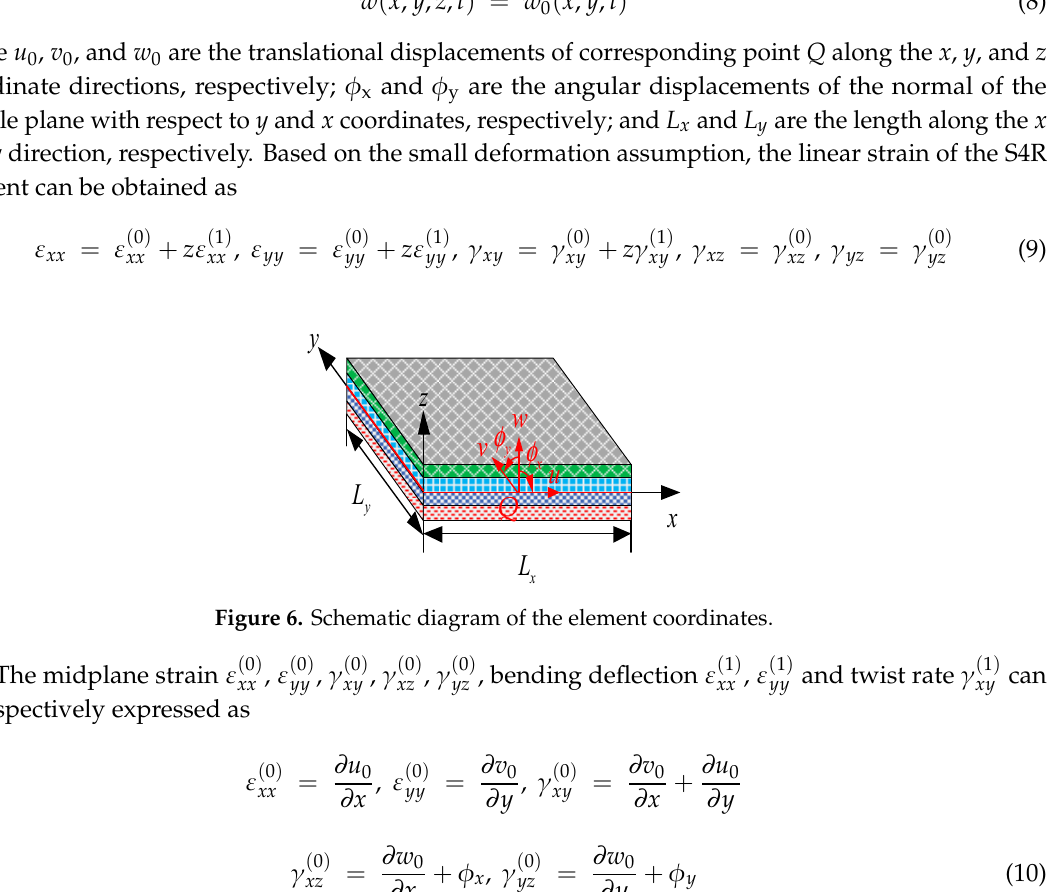
Figure 5. Schematic of the element angle in a variable-angle laminate. ( A ) Arbitrary unit A; ( B ) Arbitrary unit B; ( C ) Arbitrary unit C.